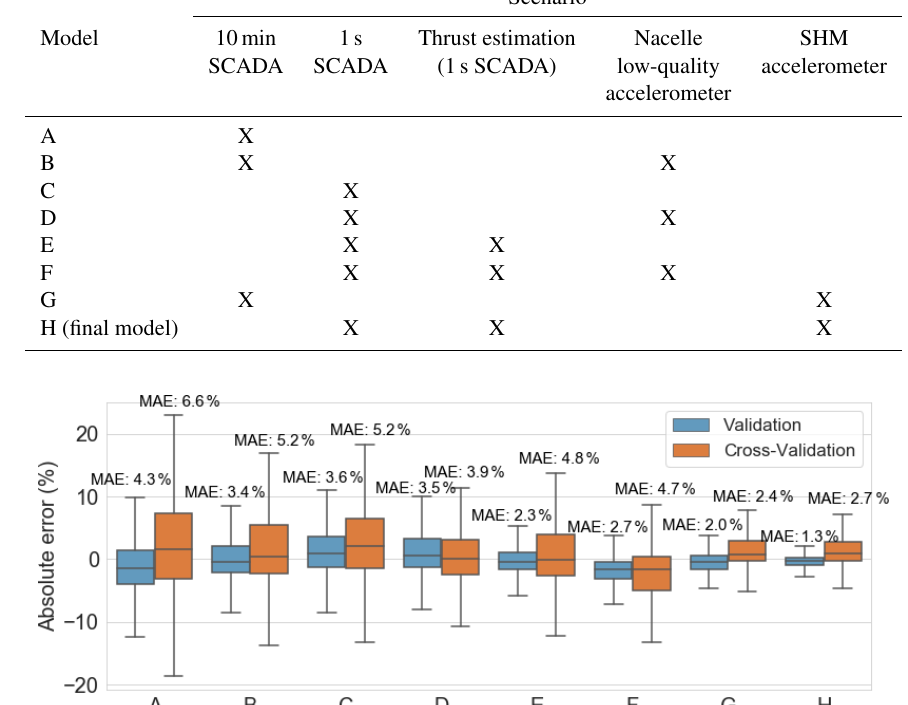
Figure 10. Comparison of the ANN model’s performance in validation and cross-validation for eight different sensor data quality scenarios. Error expressed as a percentage of the absolute maximal training DEL